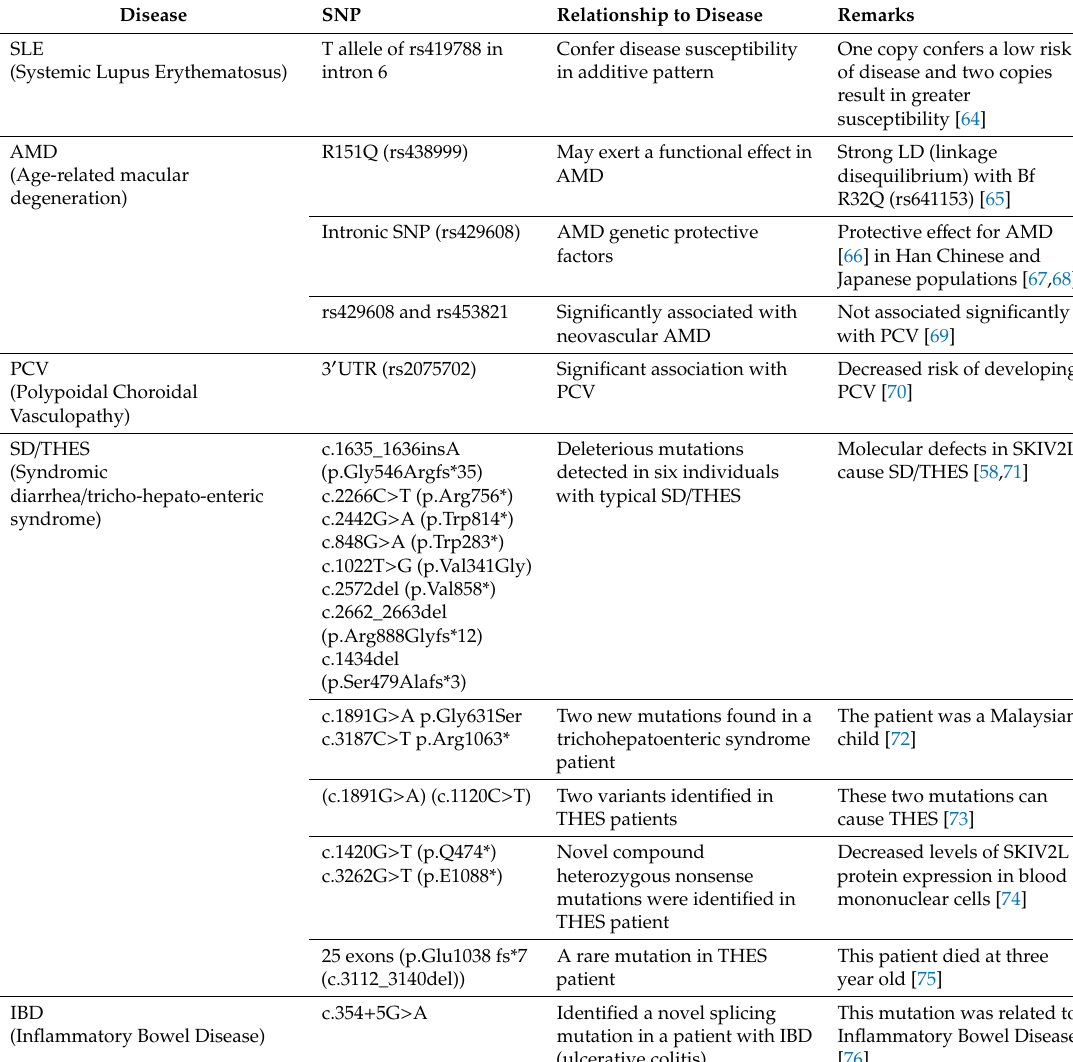
Table 2. A list of human diseases associated with mutations of